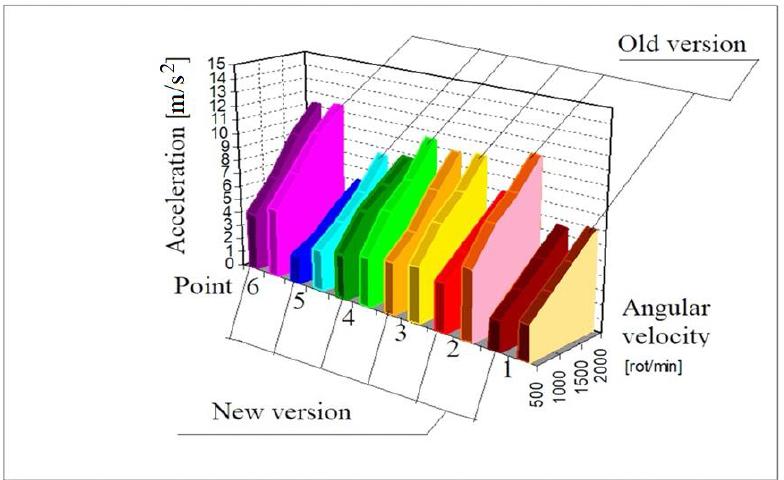
Figure 38. Synthesis of the acceleration values measured on the housings of the two adder gearboxes.